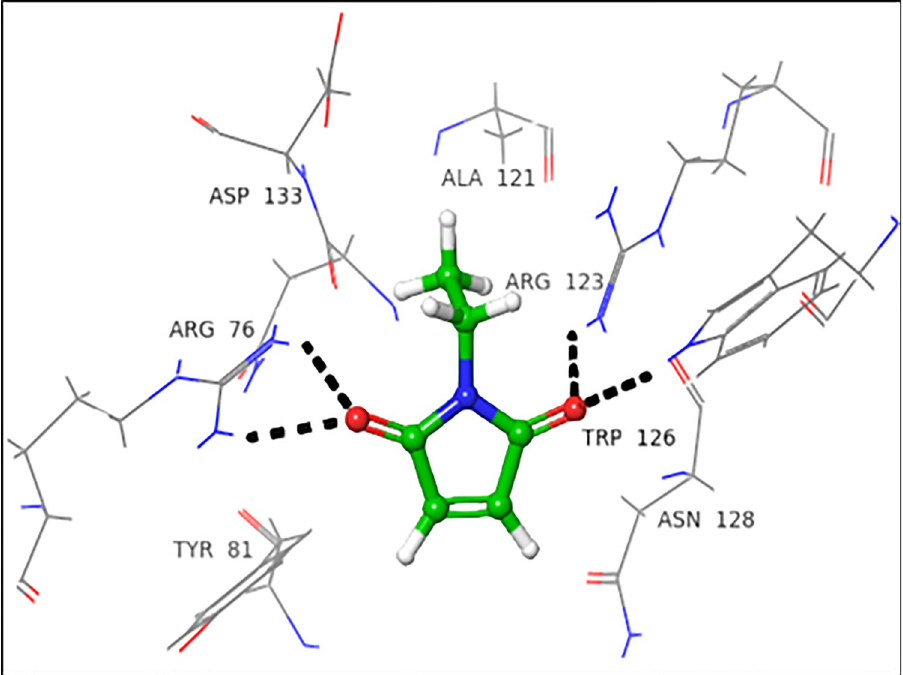
Fig 4. Interactions of NEM with acceptor active site 3ZY5. 3D Ligand interactions diagram; black dashed lines represent hydrogen bonding.